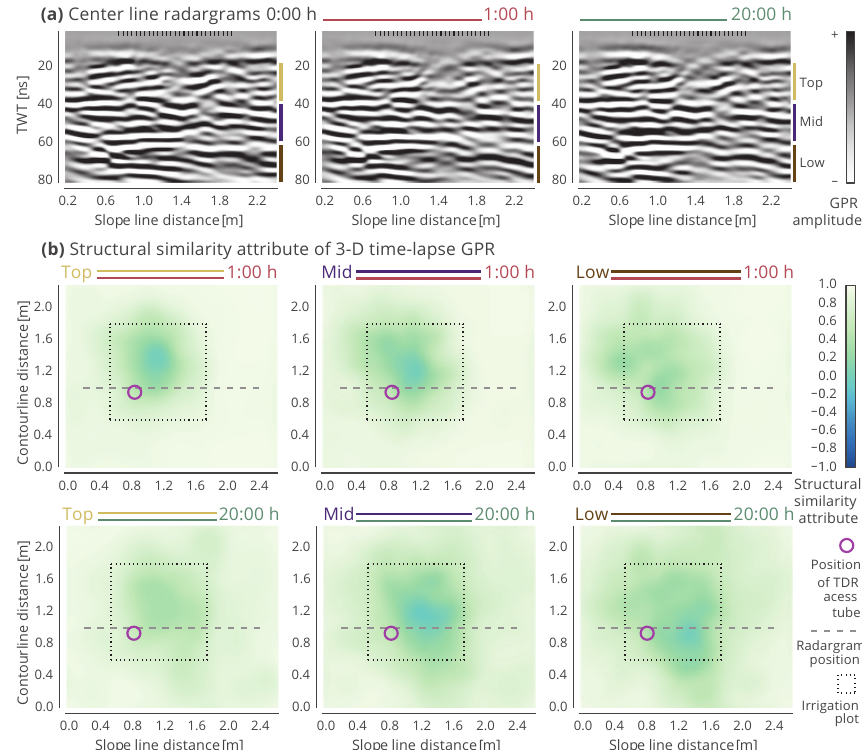
Figure D2. Time-lapse 3-D GPR of the irrigation experiment at plot XI. Center line radargrams at the marked transect (gray dashed line in the lower panels) for the three acquisition times (before 0:00h, directly after irrigation 1:00h, 20:00h after irrigation) are given in the top row. The structural similarity attribute of the 3-D data cube is given in three different depth layers (top 20–40ns, mid 40–60ns, low 60–80ns) in the lower panels. The irrigation plot is marked by a black dashed box/line. Slope line distance is increasing